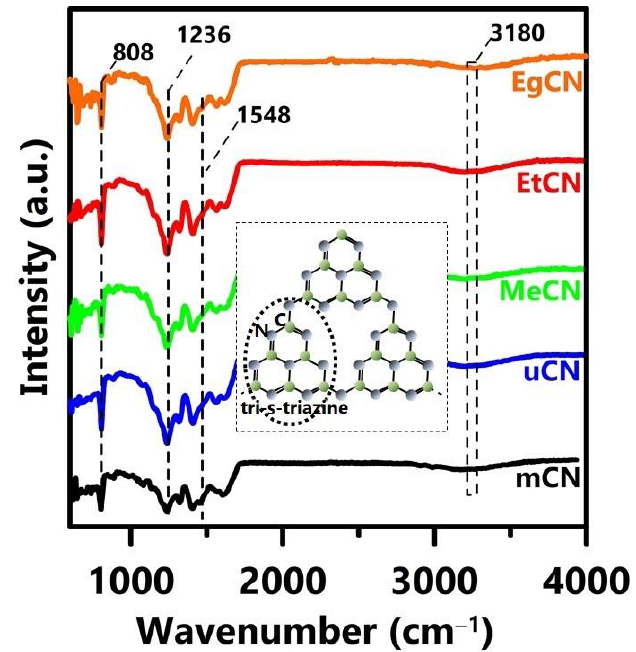
Figure 2 Figure 2. FTIR spectra of mCN, uCN, MeCN, EtCN, and EgCN samples. Inset shows the proposed molecular structure of g-C 3 N 4